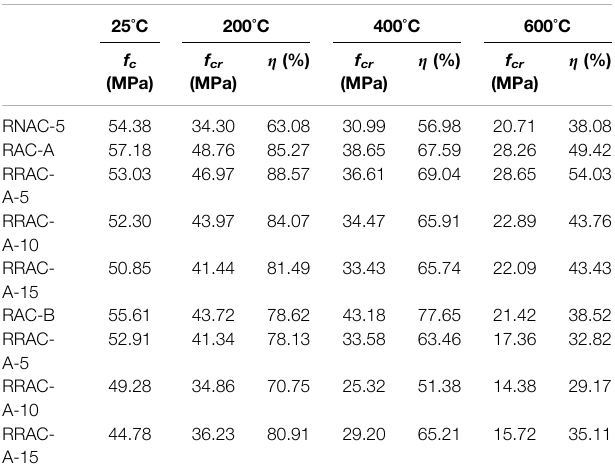
TABLE 7 | Residual compression strength after